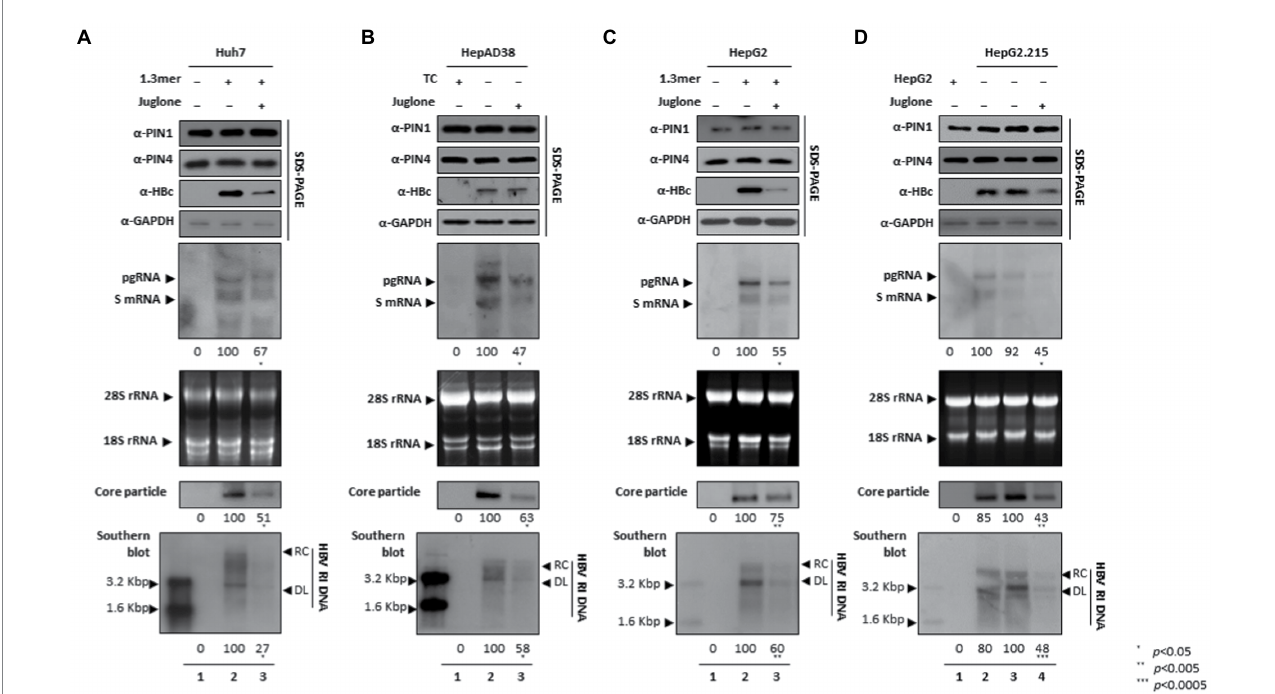
FIGURE 3 Inhibition of PIN1 and PIN4 by Juglone reduces replication of HBV in Huh7, HepAD38, HepG2, and HepG2.2.15. (A–D) Juglone reduces HBV replication. (A) The Huh7 cells were mock-transfected (lane 1), transfected with 4 μ g of 1.3 mer HBV WT and treated with ethanol (lane 2), or transfected by 1.3 mer HBV WT (4 μ g) and treated with 20 μ M of Juglone for 72 h (lane 3). (B) HepAD38 was treated with mock (none, lane 1) or ethanol (lane 2) or treated with 20 μ M Juglone (lane 3) for 72 h. (C) HepG2 cells were transfected with mock (lane 1), 1.3 mer HBV WT (4 μ g) transfected and treated with ethanol (lane 2), or 4 μ g 1.3 mer HBV WT transfected and treated with Juglone (20 μ M) for 72 h (lane 3). (D) HepG2.2.15 cells were treated with mock (none, lane 2) or treated ethanol (lane 3) or Juglone (20 μ M) treated for 72 h (lane 4). Lane 1 indicates mock-transfected HepG2 cells (negative control). The lysates were subjected to SDS- PAGE and immunoblotting, NAGE, Northern, and Southern blotting, as described previously (Piracha et al., 2018). The presented data are representative of three independent experiments. The statistical analysis was determined using Student’s t -test. * p < 0.05, ** p < 0.005, *** p < 0.0005 relative to the